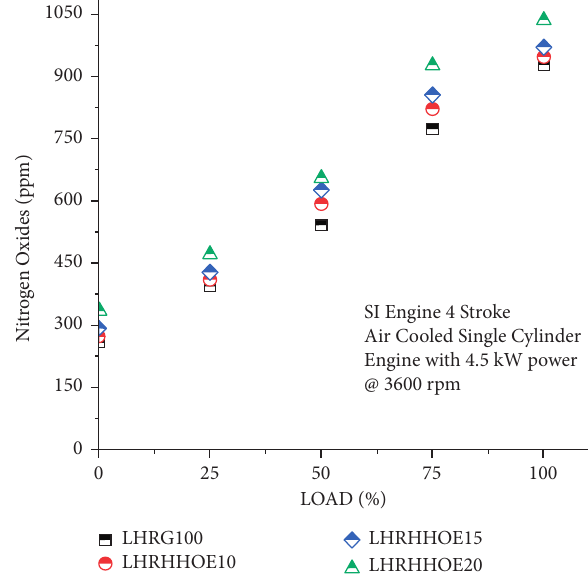
Figure 6: Study on nitrogen oxides emission on nanocoated ethanol-gasoline engine.